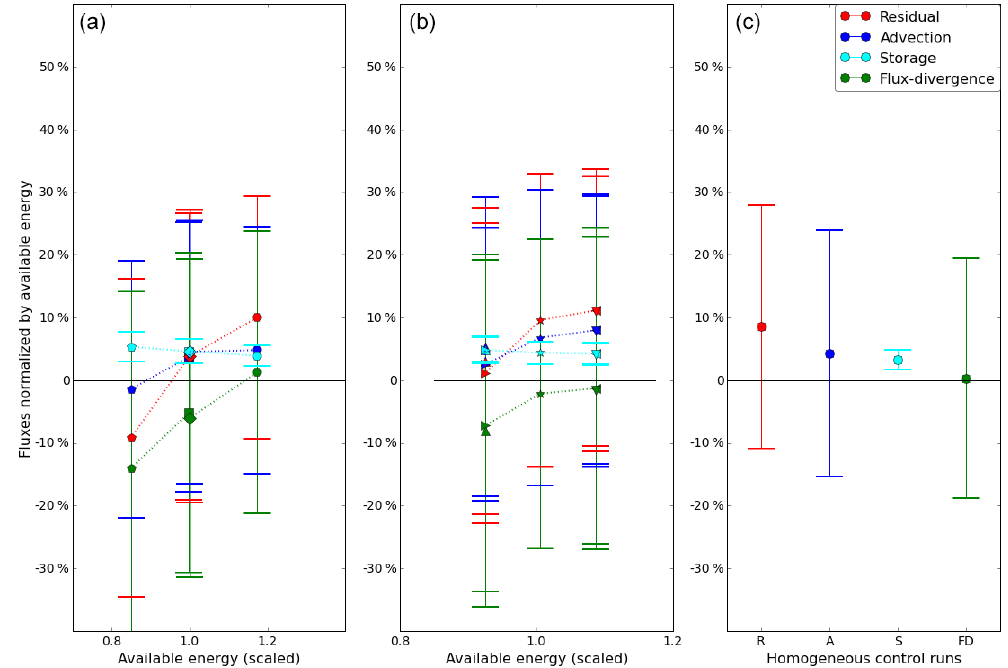
Figure 6. Control volume fluxes as a function of available energy (scaled by the median value) for hectometer scale landscape heterogeneity. See Fig. 4 for the explanation of the captions and labels and the text for further discussion.